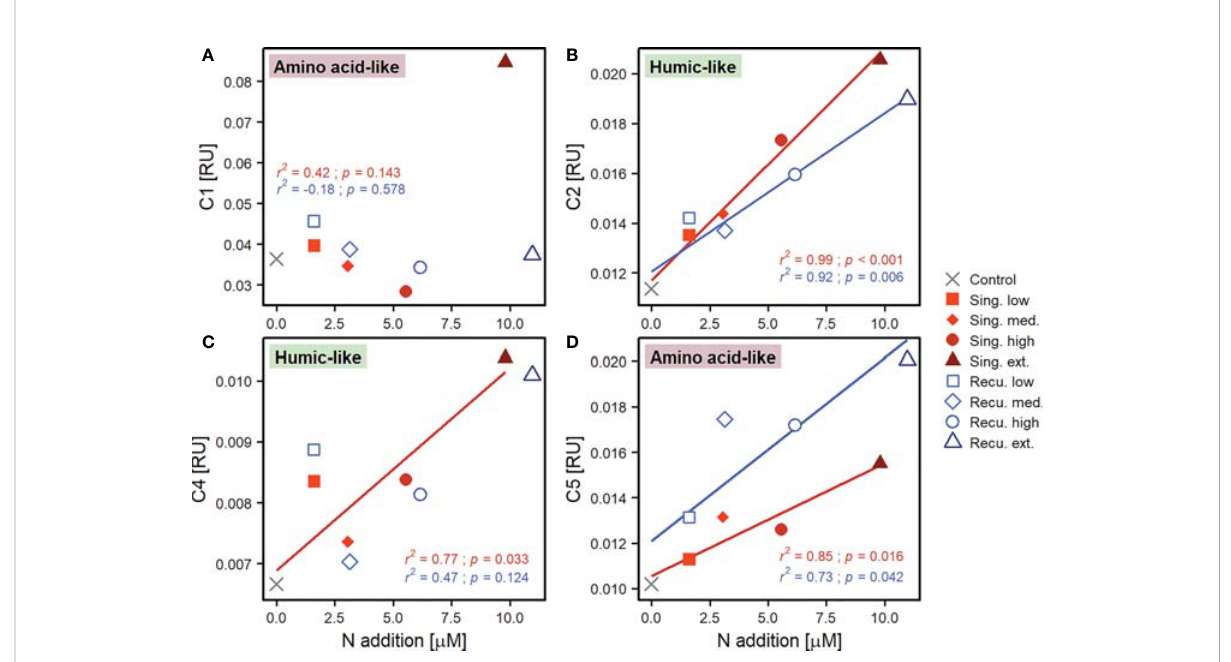
FIGURE 7 Linear regressions of average values after the last deep water addition to recurring treatments ( ≥ day 33) of FDOM components (A) C1, (B) C2, (C) C4 and (D) C5 against upwelling intensity (as N addition), per upwelling mode. The coef fi cient of determination ( r 2 ) and p-value ( p ) of the regressions are included. Only lines for signi fi cant regressions ( p < 0.05) are displayed. Regression parameters are detailed in Table